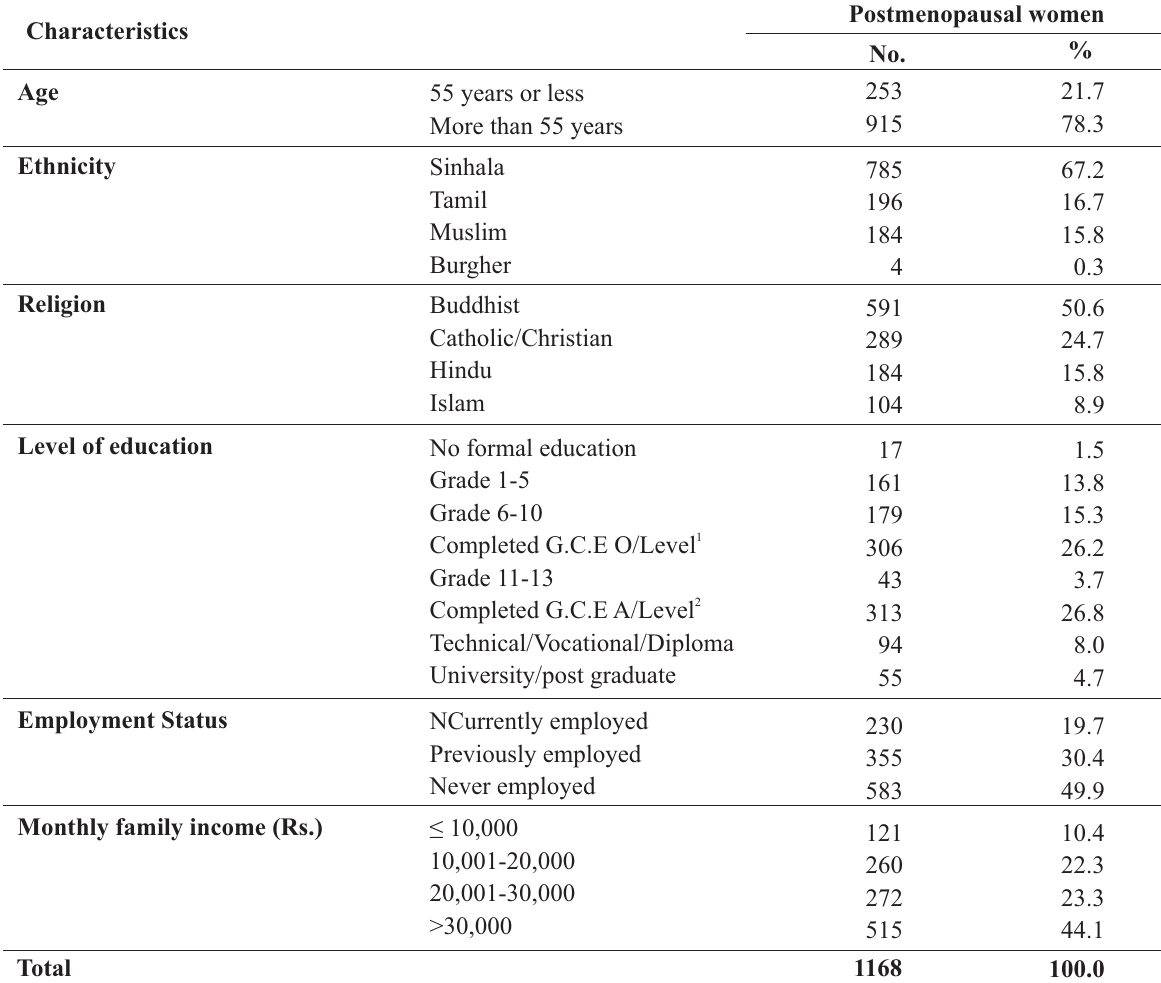
Table 2: Socio-demographic characteristics of the study population (N=1168)